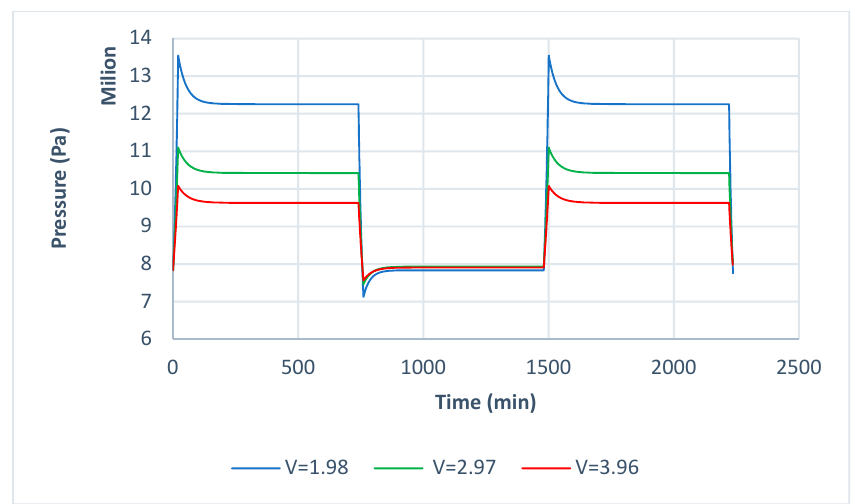
Figure 9. Gas temperature trend for the Second Configuration varying the Volume of the tank.